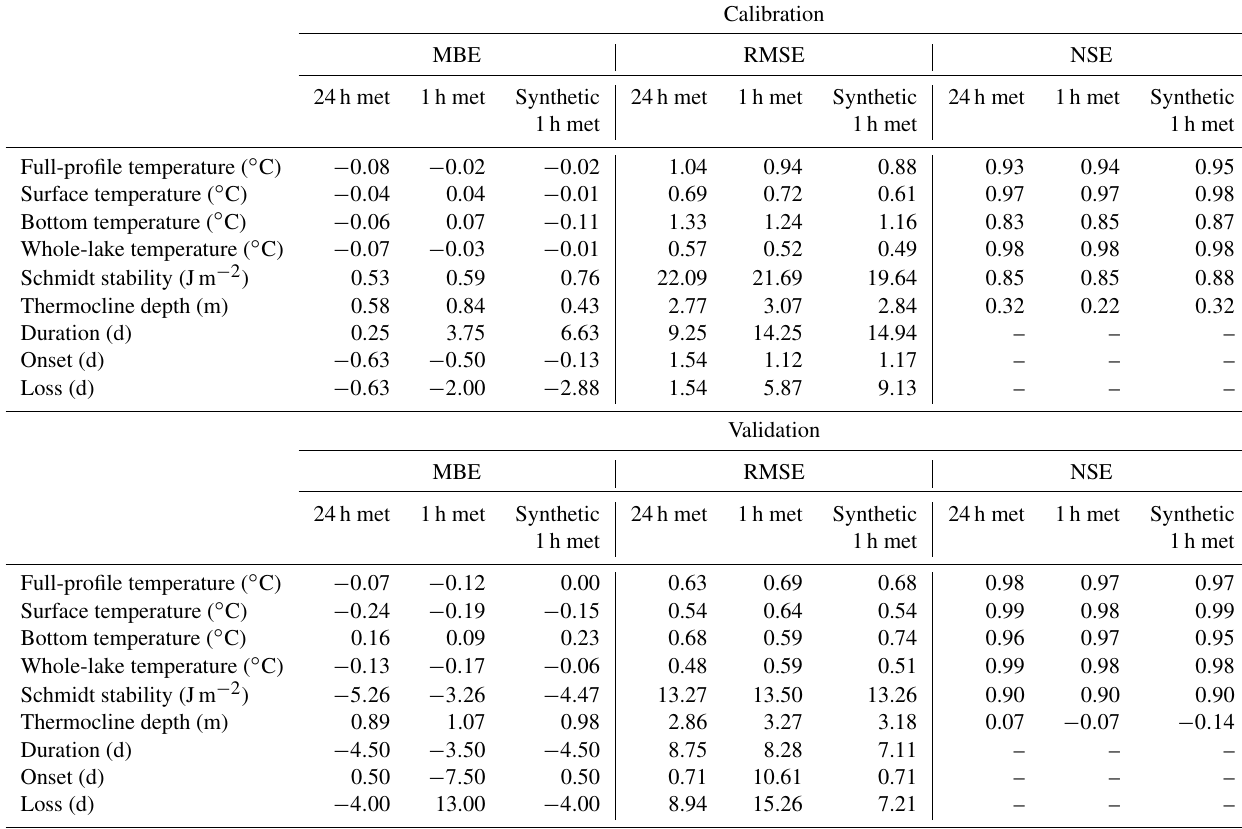
Table 4. GOTM lake model performance evaluation of MBE, RMSE, and NSE for full-profile temperature, surface temperature, bottom temperature, volumetrically weighted averaged whole-lake temperatures, Schmidt stability, thermocline depth, duration, and onset and loss of thermal stratification using simulated results from running GOTM driven by daily (24h met), hourly (1h met), and synthetic hourly (synthetic 1h met) meteorological data